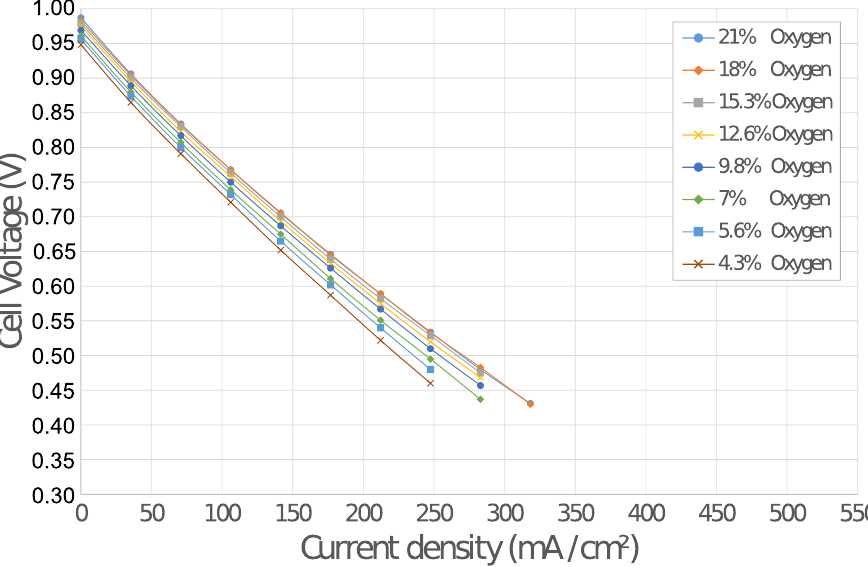
Figure 11. The performance of the cell at 800 ◦ C with decreasing partial pressure of oxygen. The ohmic losses are high and the drop in voltage is significant as the partial pressure of oxygen at the cathode